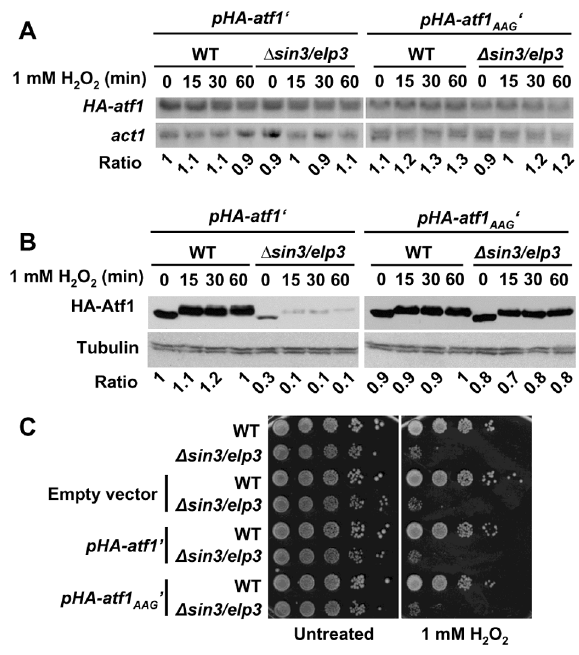
Figure 5. Expression of a synthetic AAA-to-AAG atf1 gene rendered wild-type Atf1 protein levels in Elongator mutants. (A and B) Vectors carrying a constitutively expressed wild-type (p HA-atf1 9 ) or mutated atf1 gene (p HA-atf1 AAG 9 ) were integrated in the chromo- somes of wild-type or D sin3/elp3 strains. Rich media cultures of strains JF91 (WT + p HA-atf1 9 ), JF92 ( D sin3/elp3 + p HA-atf1 9 ), JF94 (WT + p HA- atf1 AAG 9 ) and JF95 ( D sin3/elp3 + p HA-atf1 AAG 9 ), either untreated (0) or treated with 1 mM H 2 O 2 for the indicated times, were analyzed to determine HA-atf1 mRNA levels by Northern blot using an anti-HA probe (A) or HA-Atf1 protein levels by Western blot using monoclonal antibody against HA (B). The numbers below the Northern or Western blot panels indicate the relative levels of HA-atf1/act1 mRNAs (panel A) or HA-Atf1/tubulin protein levels (panel B). (C) Expression of the mutant AAA-to-AAG Atf1 protein does not suppress the growth defects of D sin3/elp3 cells upon oxidative stress. Empty vector or plasmids carrying a wild-type (p HA-atf1 9 ) or a mutated atf1 gene (p HA-atf1 AAG 9 ) were integrated in the chromosomes of wild-type or D sin3/elp3 strains. Cultures from the resulting strains JF88 (WT + empty vector), JF89 ( D sin3/ elp3 + empty vector), JF91 (WT + p HA-atf1 9 ), JF92 ( D sin3/elp3 + p HA-atf1 9 ), JF94 (WT + p HA-atf1 AAG 9 ) and JF95 ( D sin3/elp3 + p HA-atf1 AAG 9 ) were serially diluted and spotted onto rich media plates without (Untreated) or with 1 mM H 2 O 2